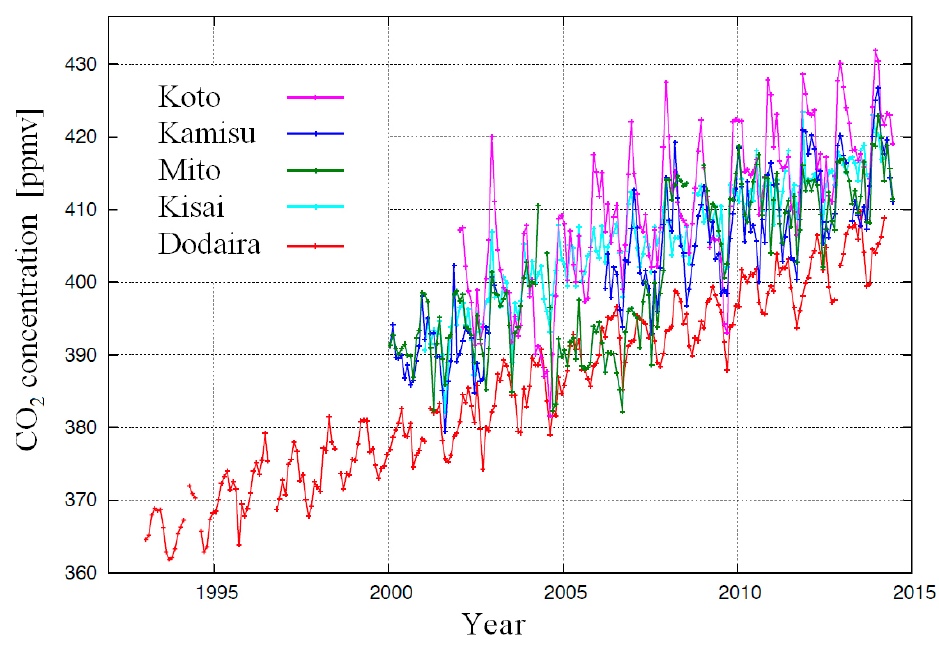
Figure 3. Monthly mean CO 2 concentrations observed at five sites.